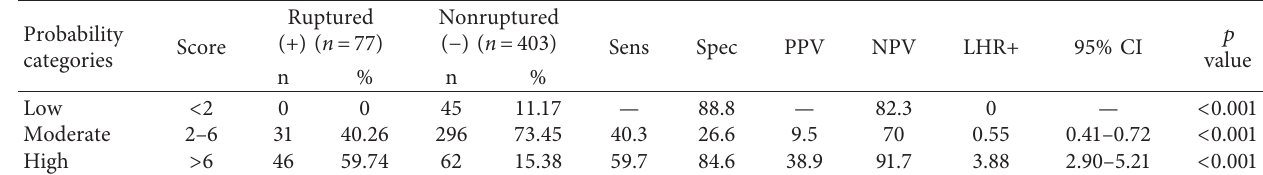
Table 3: Probability categories in the RAMA WeRA Risk